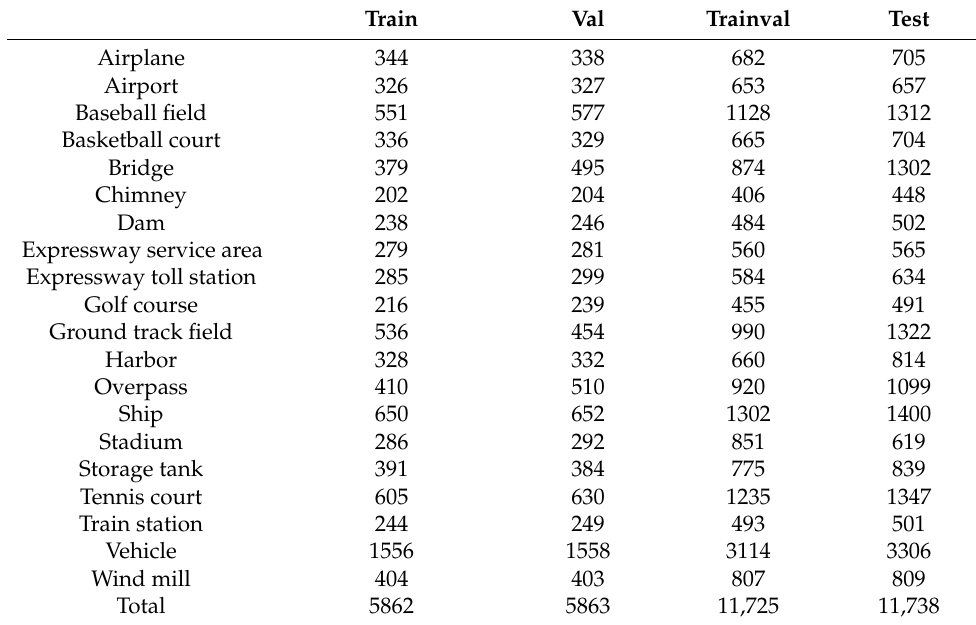
Figure 9. All 20 classes object ( a – t ) in DIOR dataset. ( a ) Airplane; ( b ) Airport; ( c ) Baseball field; ( d ) Basketball court; ( e ) Bridge; ( f ) Chimney; ( g ) Dam; ( h ) Expressway service area; ( i ) Expressway toll station; ( j ) Golf course; ( k ) Ground track field; ( l ) Harbor; ( m ) Overpass; ( n ) Ship; ( o ) Stadium; ( p ) Storage tank; ( q ) Tennis court; ( r ) Train station; ( s ) Vehicle; ( t )